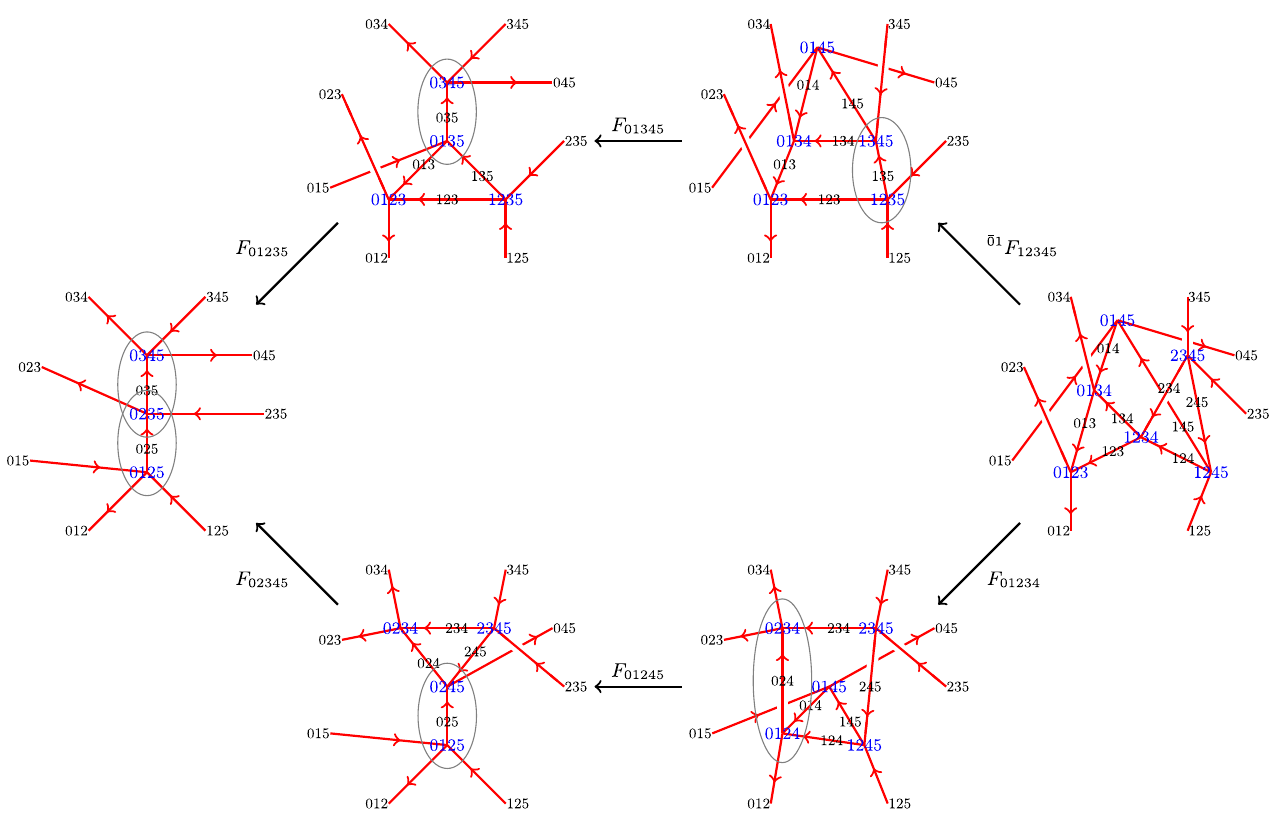
FIG. 12. Superfusion hexagon equation on the lattice dual to triangulation in Fig. 11. Each meeting point of four red links should be resolved to a small tetrahedron as in Fig.